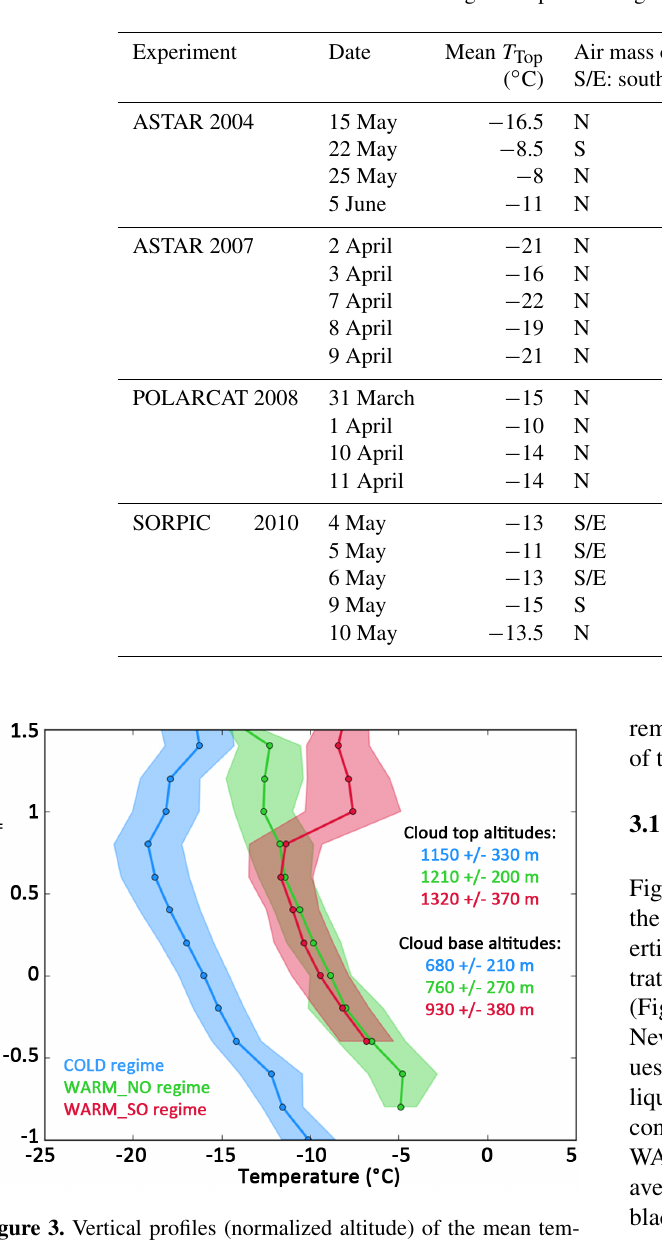
Figure 3. Vertical profiles (normalized altitude) of the mean tem- perature for each regime. Shaded spreads represent the standard de- viation. The mean cloud base and top altitudes and their standard deviation for each regime are